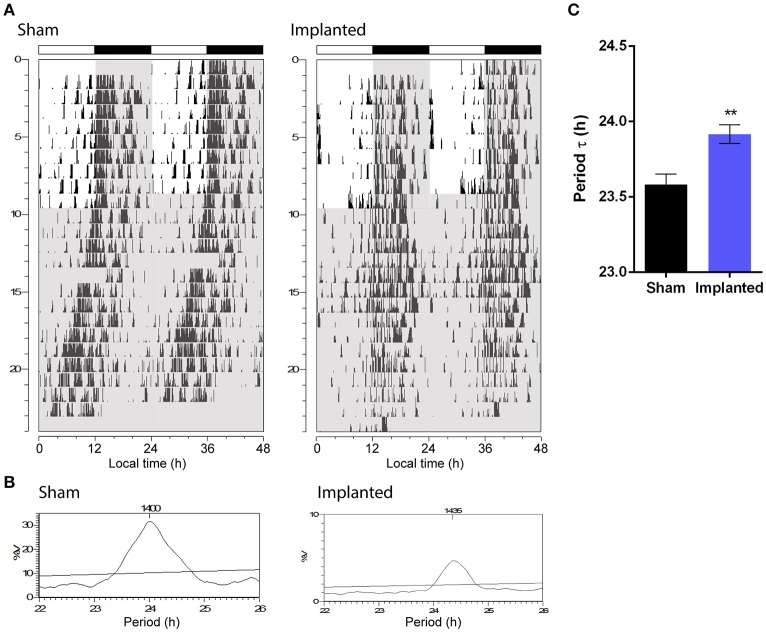
Hypothalamic glioma alters endogenous circadian timekeeping. (A) Representative actograms of control (sham) and implanted animals. Gray background indicates lights-off. (B) Representative Sokolove-Bushell's periodograms for sham and implanted animals showing the endogenous circadian period. (C) Hypothalamic tumors increase the endogenous circadian period (23.92 ± 0.06 h, n = 9 and 23.58 ± 0.07, n = 6, for implanted and control (sham) animals, respectively; **p < 0.01, Student's t-test).